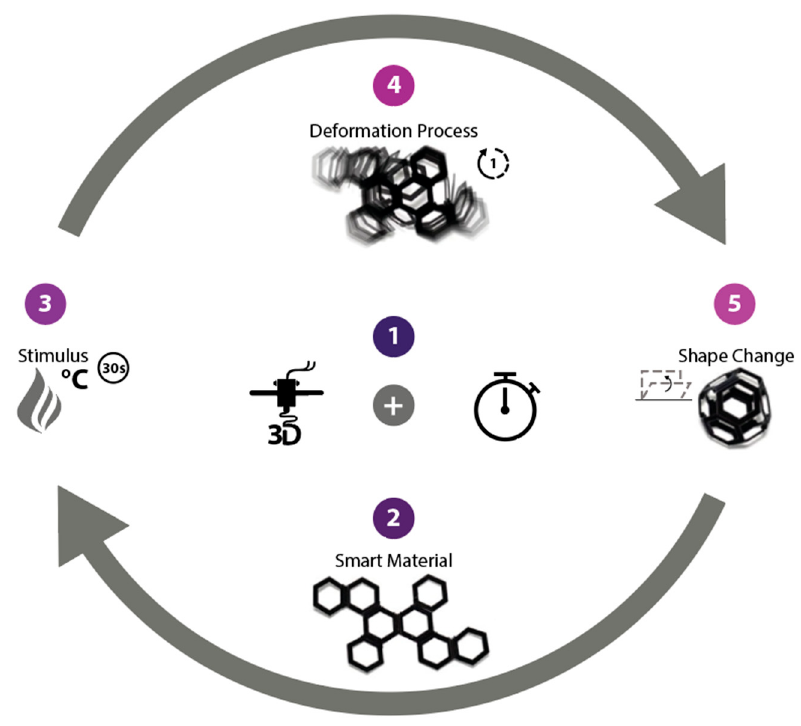
Figure 2. 4D Printing